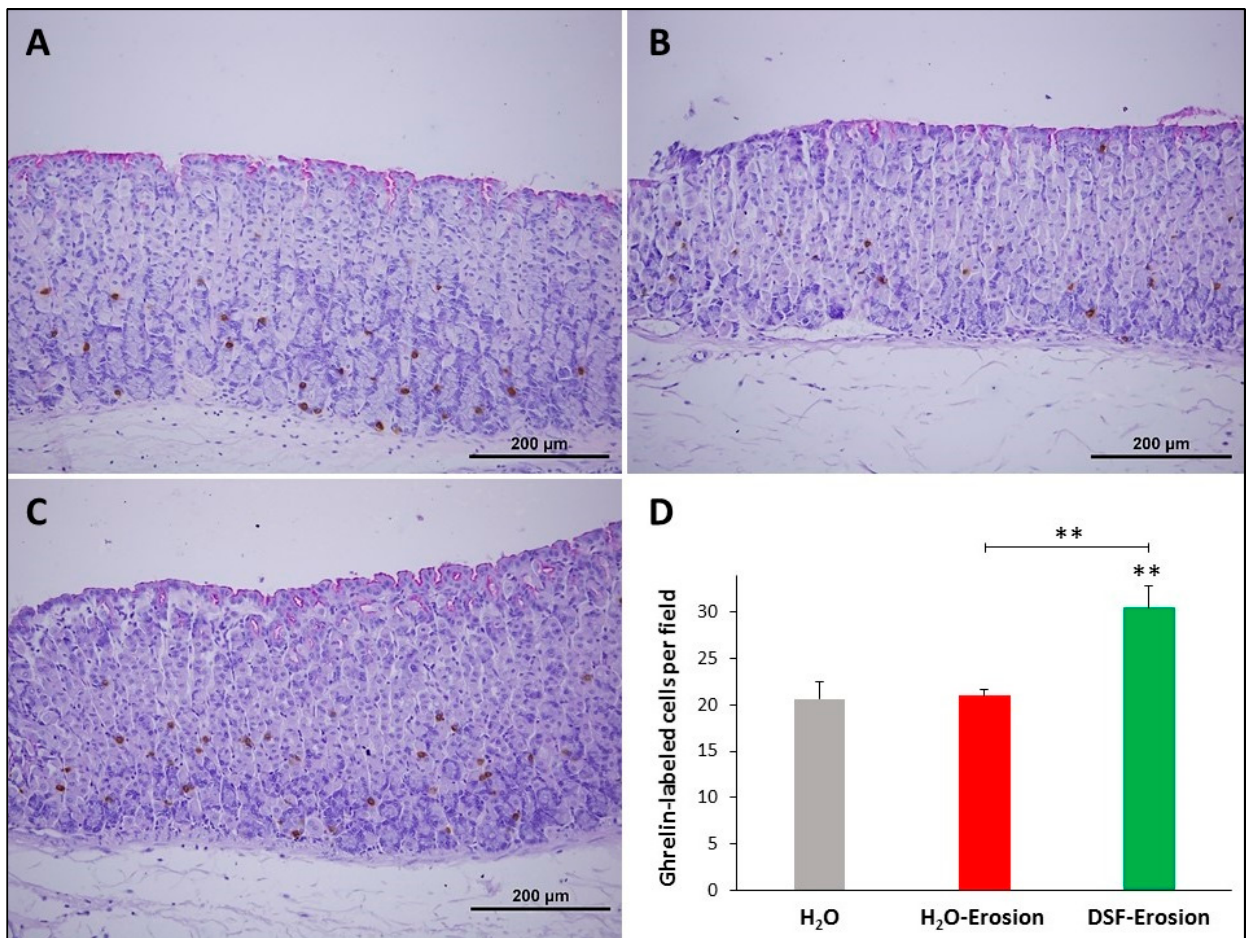
Figure 10. Ghrelin immunolabeling in the gastric mucosae of H 2 O control ( A ), erosion-induced ( B ) and DSF-erosion ( C ) mice. The tissue sections were counterstained with PAS and hematoxylin. Small brownish ghrelin-labeled cells are seen scattered mostly in the basal regions of the gastric mucosae. ( D ) Quantification of ghrelin-labeled cells per field of the mucosa of three mice in each group is presented as mean ± SE. ** p < 0.01; scale bar = 200 µm.